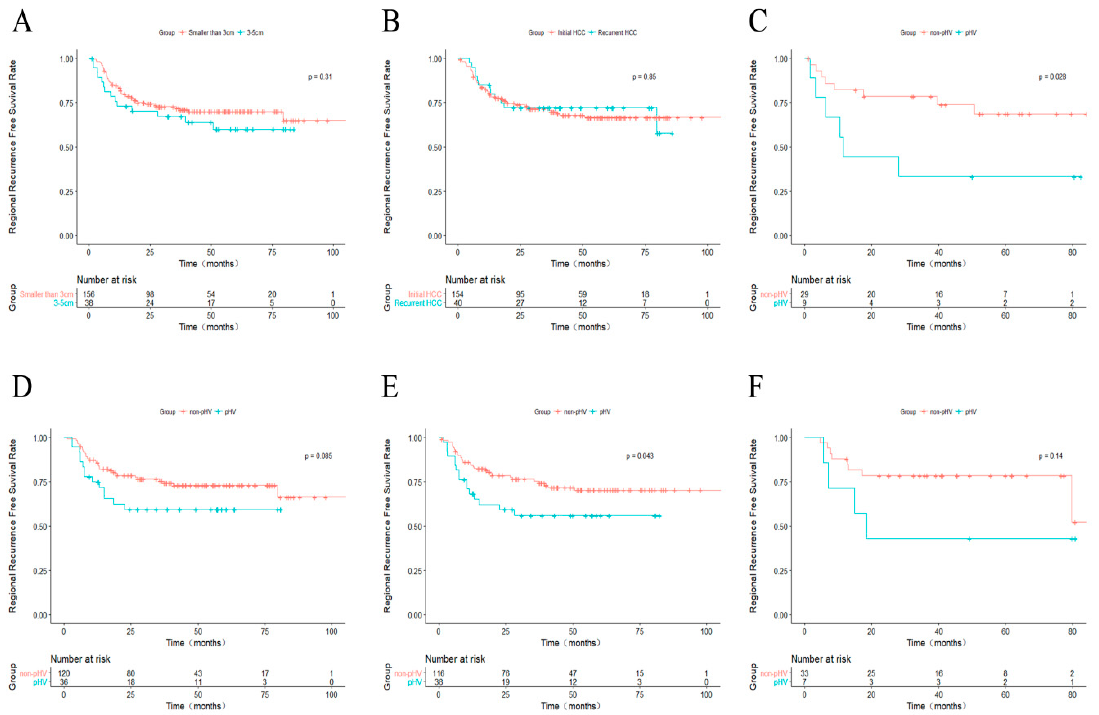
Figure 3. Kaplan–Meier curves comparing rRFS. ( A ) between HCCs smaller than 3 cm and 3–5 cm; ( B ) between initially diagnosed HCCs and recurrent HCCs; ( C – F ) between non-pHV and pHV HCCs in stratified subgroups. ( C ) HCCs between 3 and 5 cm; ( D ) HCCs smaller than 3 cm; ( E ) initially diagnosed HCCs; ( F ) recurrent HCCs. rRFS: regional recurrence-free survival; HCC: hepatocellular carcinoma; pHV: peri-hepatic vein.